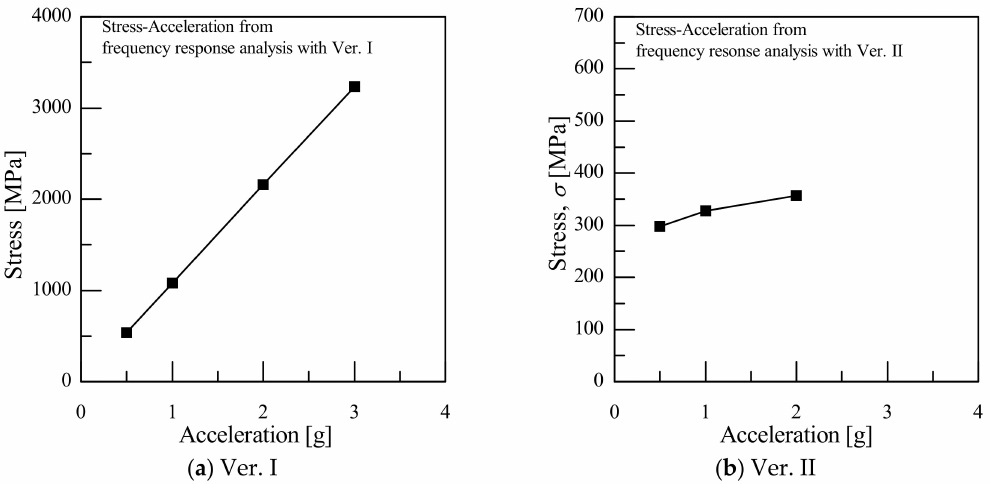
Figure 11. Maximum stress response from frequency response analysis for